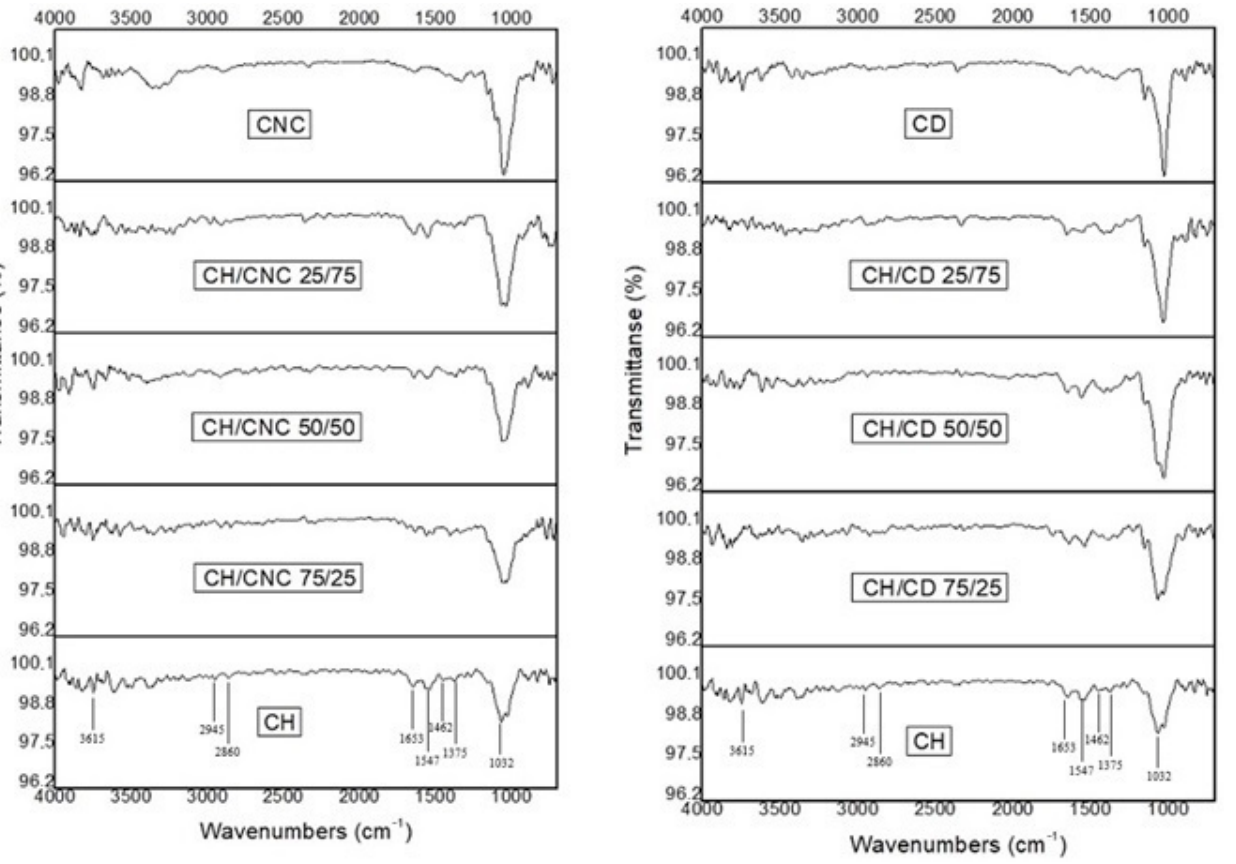
Figure 1. Fourier-transform infrared spectroscopy (FTIR) of CH/CNC and CH/CD final formed edible films.